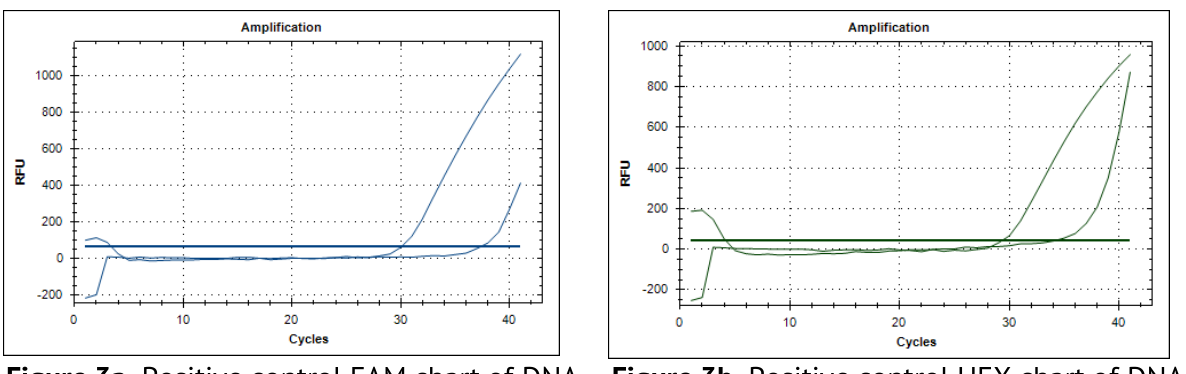
Figure 3a. Positive control FAM chart of DNA amplification.